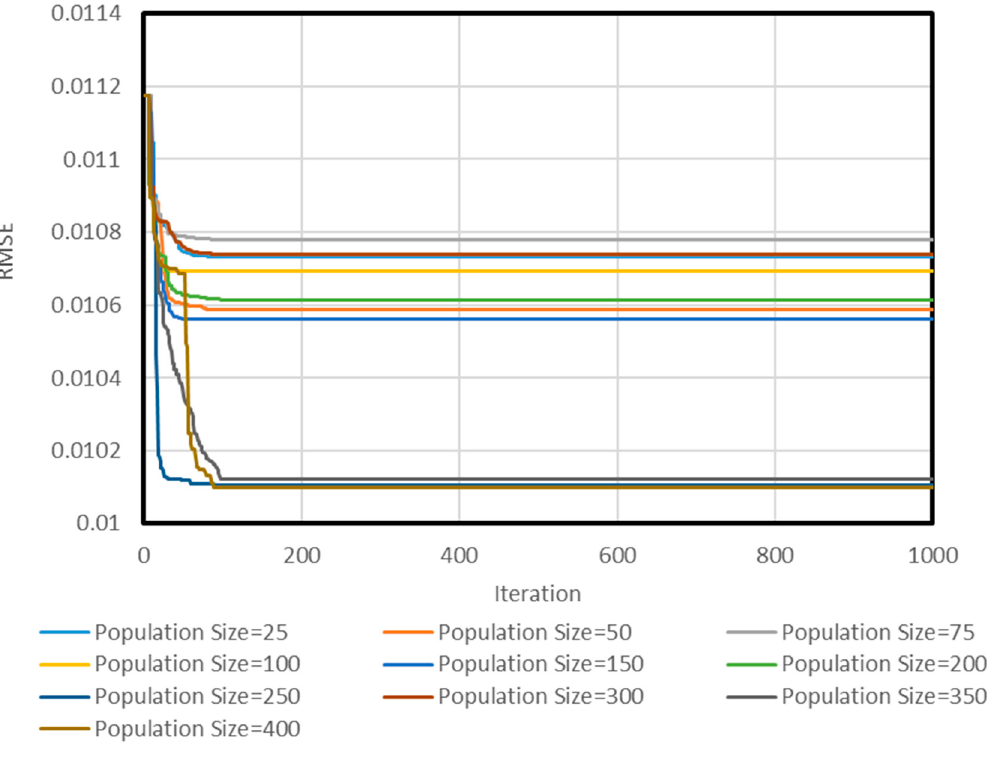
Figure 9. Efficiency results for various population sizes.